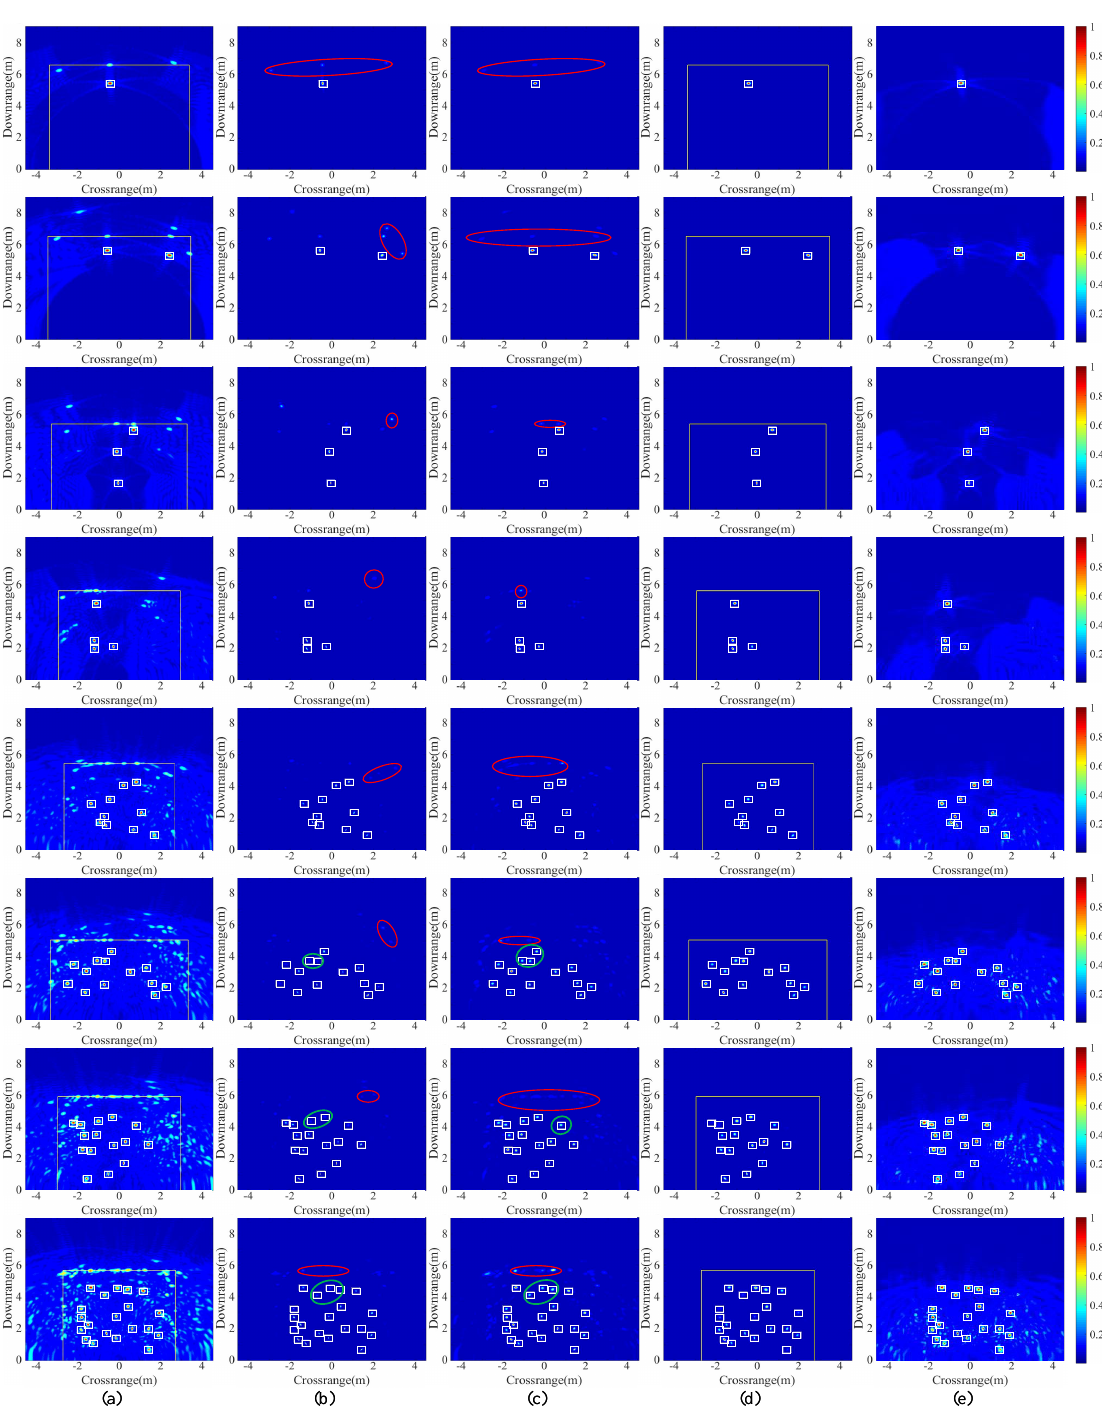
Figure 11. The comparison results of different methods. ( a ) The original images. ( b ) The PCF method [11]. ( c ) The subaperture-fusion method [8]. ( d ) The imaging-dictionary-based method [7]. ( e ) The proposed method. The yellow lines mark the walls’ locations, which indicate that the imaging-dictionary-based method requires prior wall location information. The red ellipses mark a part of the multipath ghost locations. The green ellipses mark a part of the degraded target images. The white rectangles mark the targets’